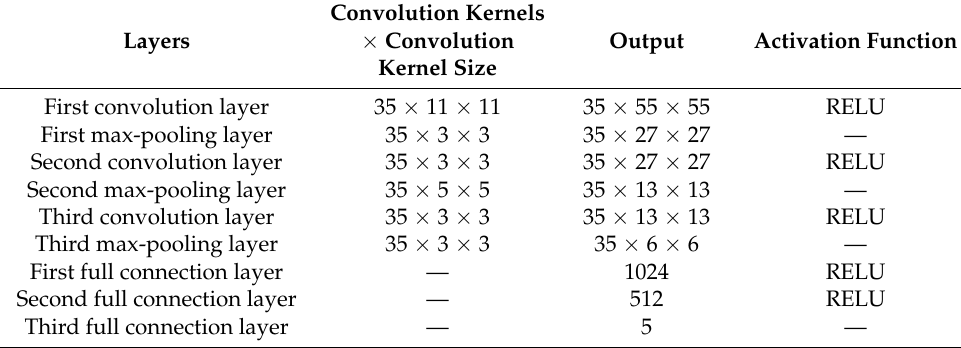
Table 2. Parameters of each layer.